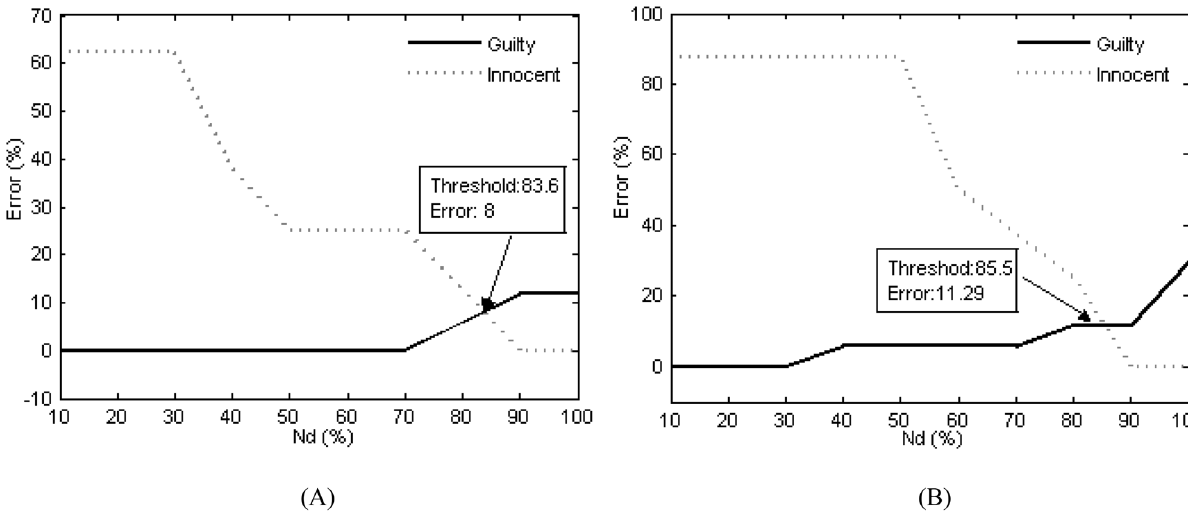
Figure 10. The detection error rates of two groups of subjects. 10A: The detection error rate of the guilty and innocent groups for BAD method. 10B: The detection error rate of the guilty and innocent groups for BCD method.